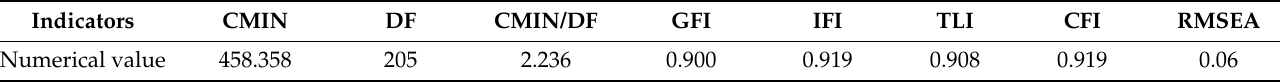
Table 4. Indicators of SRC type model